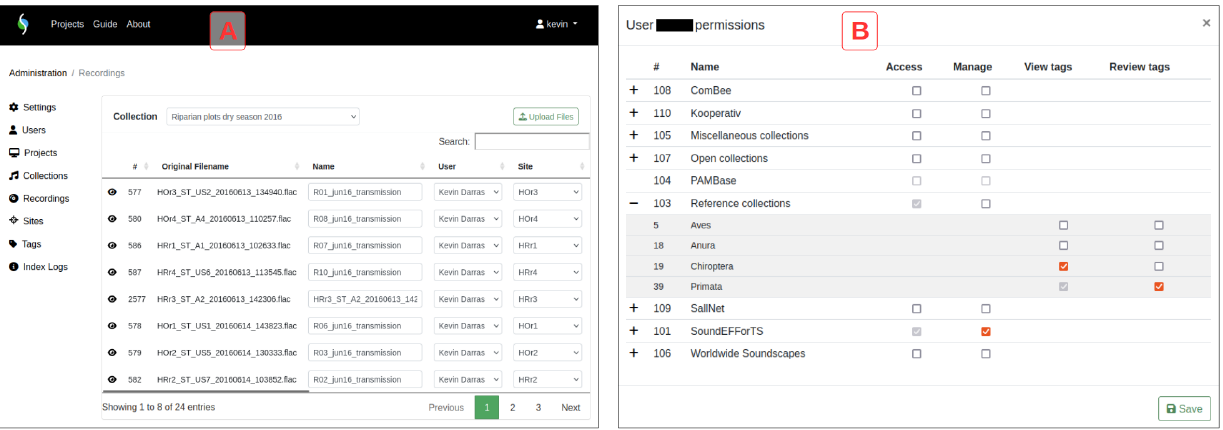
Figure 3. The administrative interface for project managers and administrators. The recording management tab ( A ), and the user privileges window ( B ).